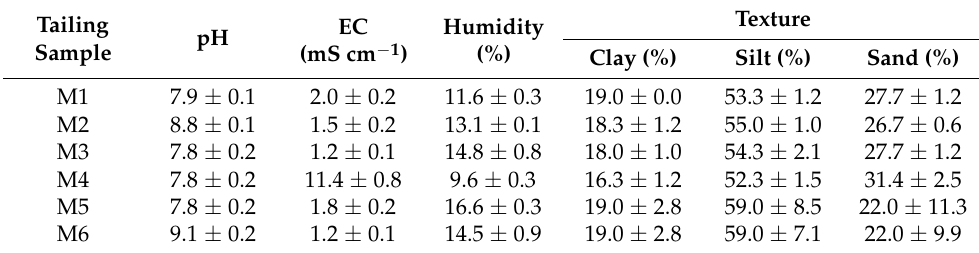
Table 1. General properties of surface tailings collected from Yamana Gold mine and control site.